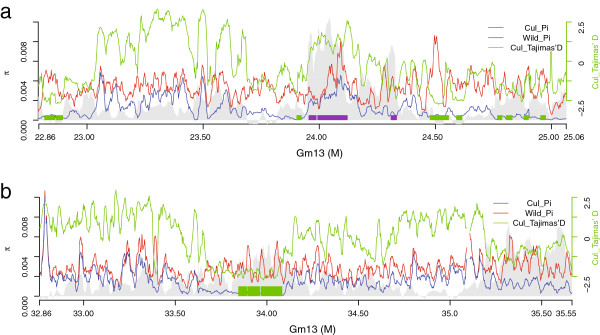
The gene diversity of genomic regions of seed size (a) and seed coat blooming (b) on chromosome 13. Top, Tajima’s D (green line); LE PBS (gray shading). Genomic diversity of wild group (red dotted line) and cultivated group (blue dotted line) displayed by π (pi) are plotted using 500 kbp sliding windows. The square frames along the chromosome indicate regions selected during domestication (green) and genetic improvement (purple).